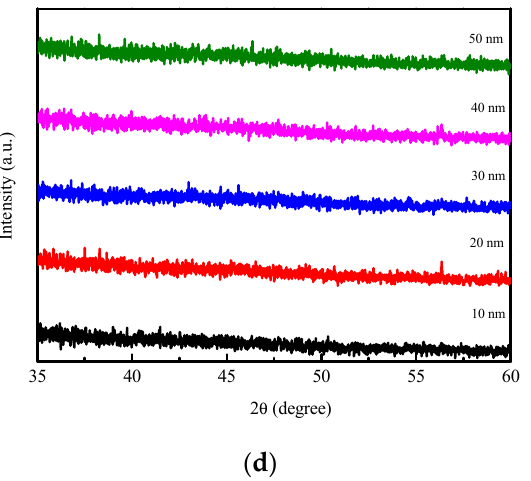
Figure 1. X-ray diffraction patterns of CoFeY thin films. ( a ) RT, ( b ) post-annealing at 100 °C, ( c ) post- annealing at 200 °C, and ( d ) post-annealing at 300 °C.